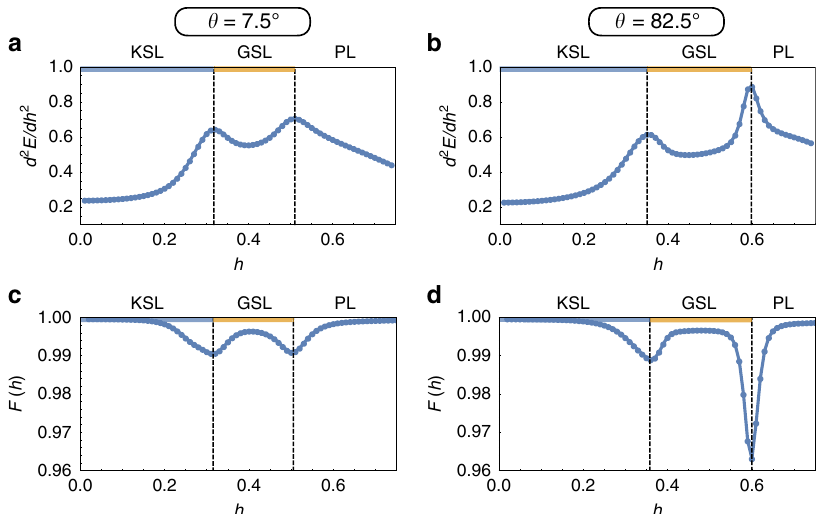
Fig. 9 Clear numerical signatures of phase transitions. In a , b the second derivative of the ground-state energy and c , d the ground-state fi delity is shown. These cuts correspond to the dashed lines (red) in Fig.